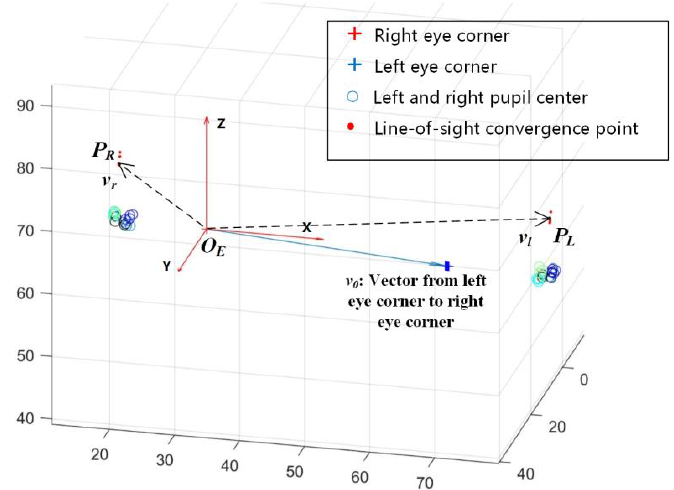
Figure 13. The origin of the eye coordinate system is built on the right eye corner point; the axis direction and the scale factor are consistent with the camera coordinate system. The blue arrow shows the inner eye corner vector from the left eye corner to the right eye corner. When the position and posture of the face changes, the position of the line-of-sight convergence point can be obtained by calculating the rotation and translation matrix between the new inner eye corner vector and the initial reference in the calibration